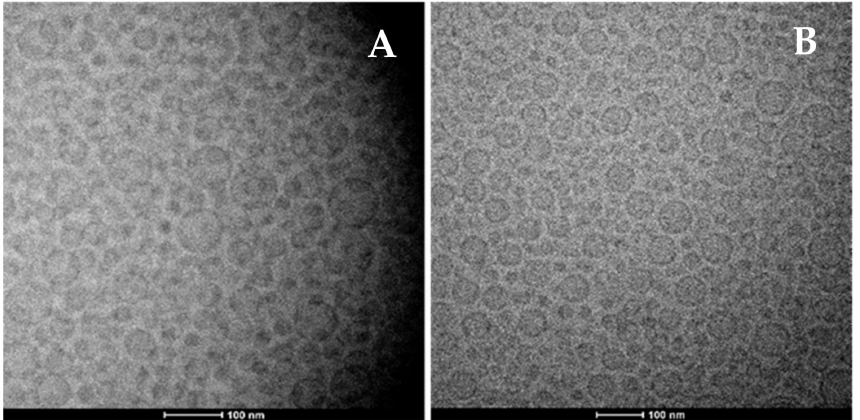
Figure 2. Representative cryo-TEM images of vesicles loading quercetin (15 mg/mL) and 25 mg/mL of mint oil (( A ), left panel), or quercetin (15 mg/mL) and 200 mg/mL of mint oil (( B ), right